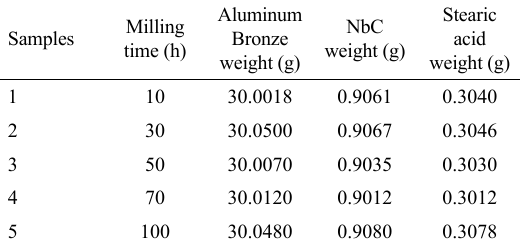
Table 1. Mixtures composition for milling